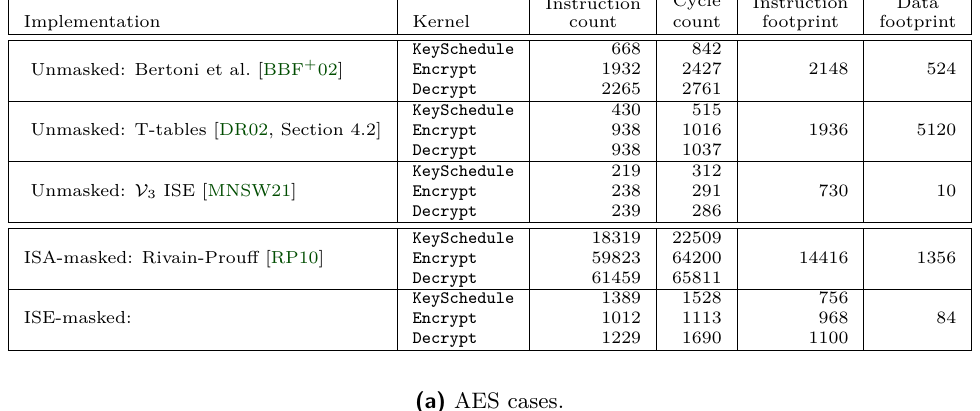
Table 5: Comparison of a) cycle count (i.e., execution latency), b) instruction count (i.e., number of instructions executed), c) instruction footprint (measured in bytes), and d) data footprint (measured in bytes), for unmasked, ISA-masked, and ISE-masked implementations of various cryptographic kernels as executed on the SCARV core. Instruction and data footprint entries with only one value represent the total size for Encrypt , Decrypt , and KeySchedule